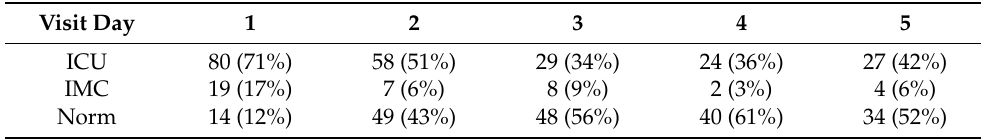
Table 3. Positive POD tests per visit day on the different wards.